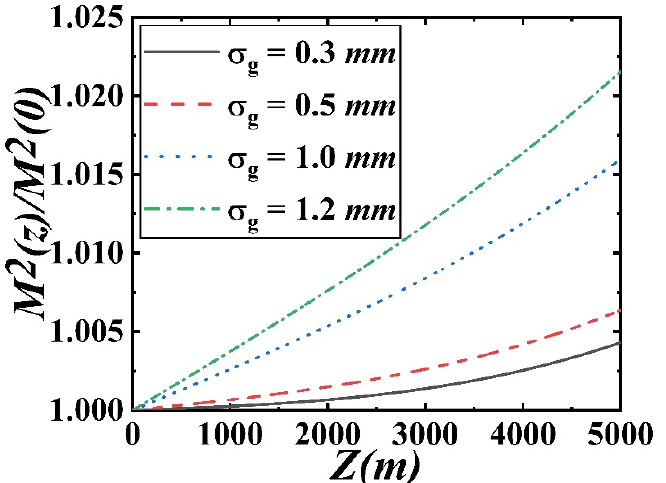
Figure 8. Dimensionless quantity M 2 ( z ) / M 2 ( 0 ) of a partially coherent Airy beam in non-Kolmogorov turbulence versus propagation distance for different σ g